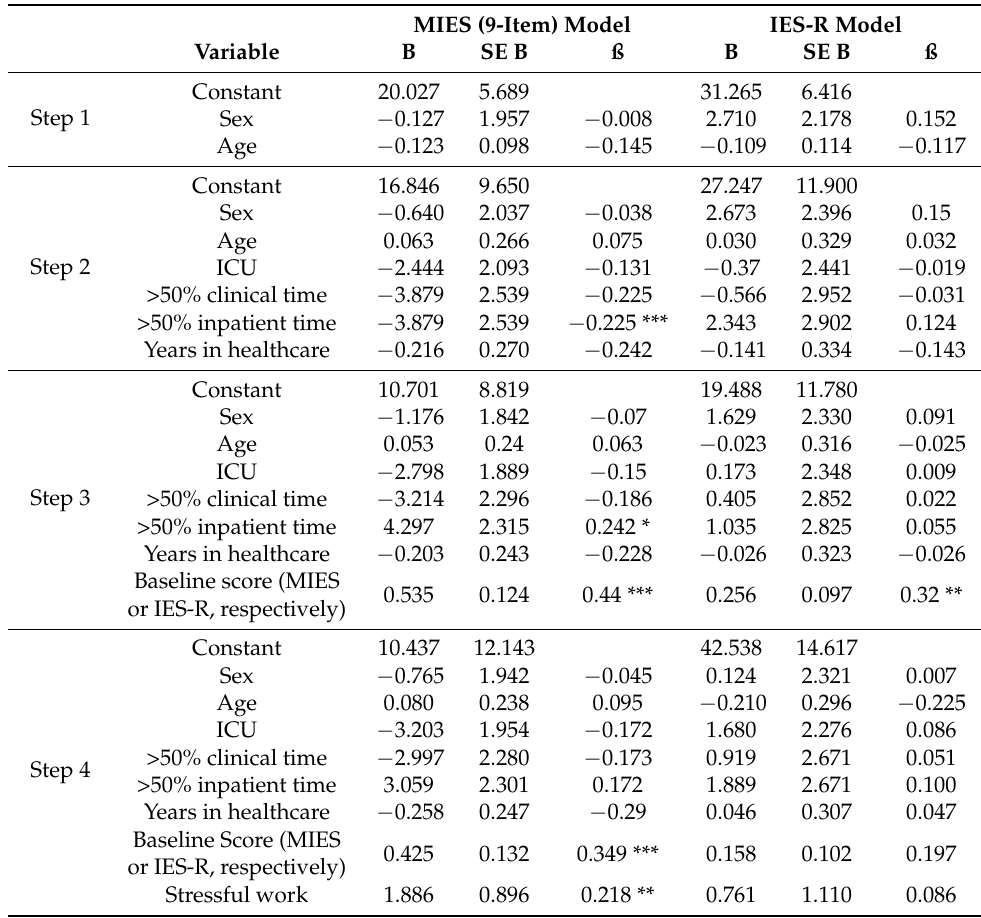
Table 3. Summary of Hierarchical Regression for Variables Predicting Three Month Moral Injury Event Score (MIES (9-item)) and Impact of Events Scale—Revised (IES-R), n =